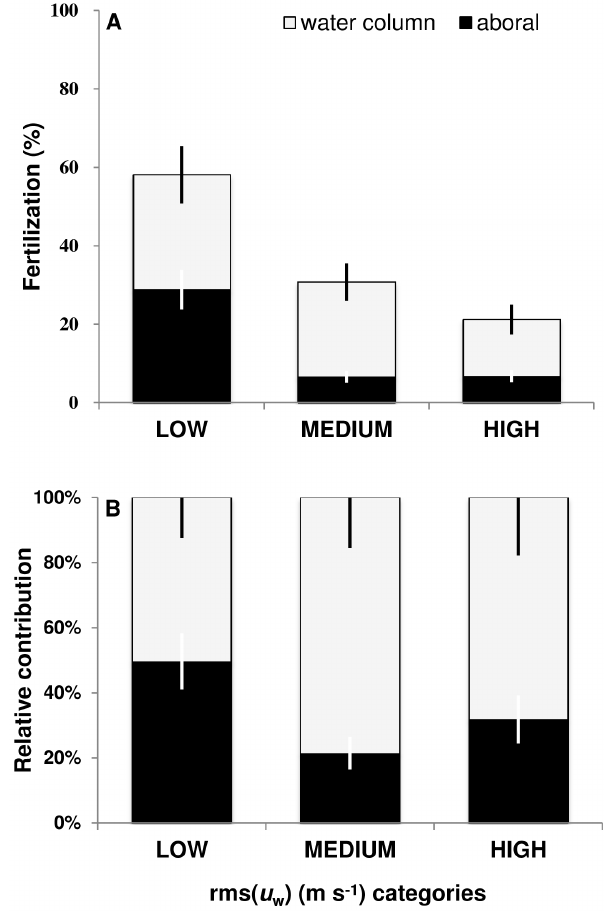
Figure 5. Importance of location for egg fertilization. Estimate of (A) the percentage of the total number of eggs spawned that were fertilized (PTF) and (B) the relative contribution to overall fertilization (RCO) at the aboral surface and water column as a function of rms( u w ) categories: LOW ( , 0.03 m s 2 1 ), MEDIUM ( . 0.03 , 0.06 m s 2 1 ) and HIGH ( . 0.06 m s 2 1 ). column with approximately 25% of the eggs being fertilized